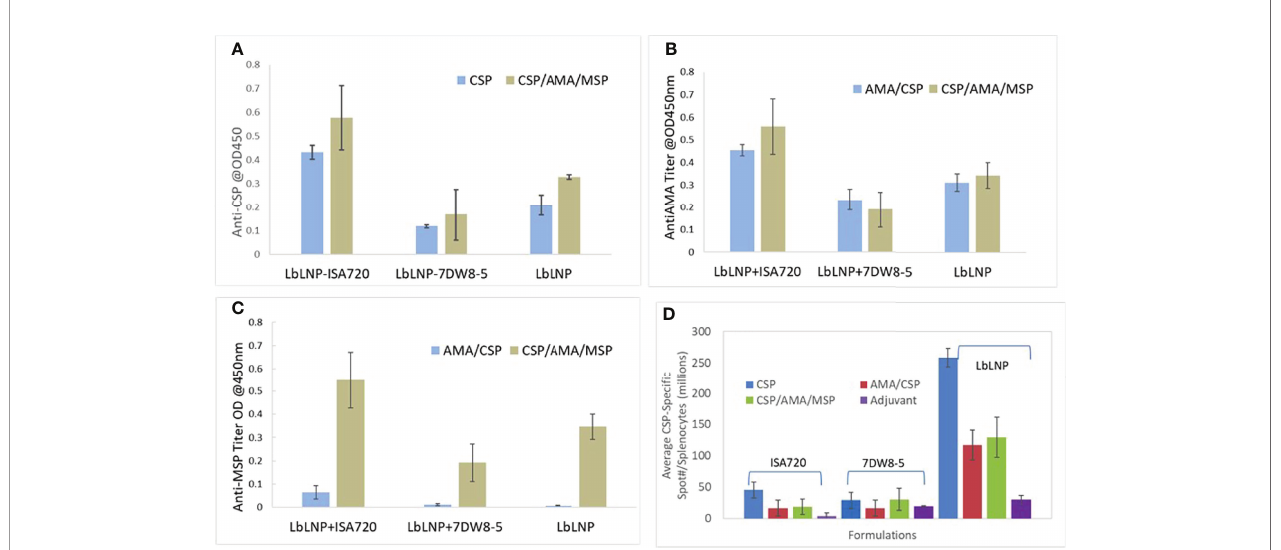
FIGURE 8 | ELISA of anti-CSP (A) , anti-AMA-1 (B) and anti-MSP-1 (C) induced by 2 doses of immunization of different vaccine candidates incorporated with and without adjuvant ISA 720 and 7DW8-5. Each group has four mice, and the data were averaged from these 4 mouse sera at 20,000 dilutions. (D) PfCSP of P. falciparum -speci fi c T cell responses (IFN- g ELISPOT) induced by immunization with LbL NP formulations and compared with two other adjuvants ISA 720 and 7DW8-5 using in the vaccine formulations for BALB/c mice study by 2-dose intramuscular